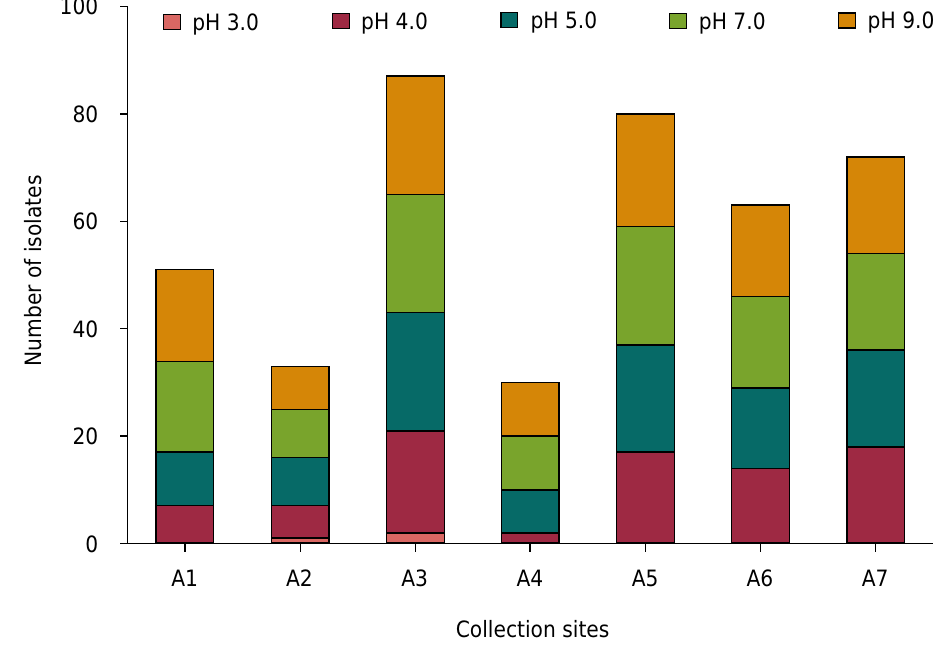
Figure 2. Number of pH tolerant bacterial isolates from each representative area.